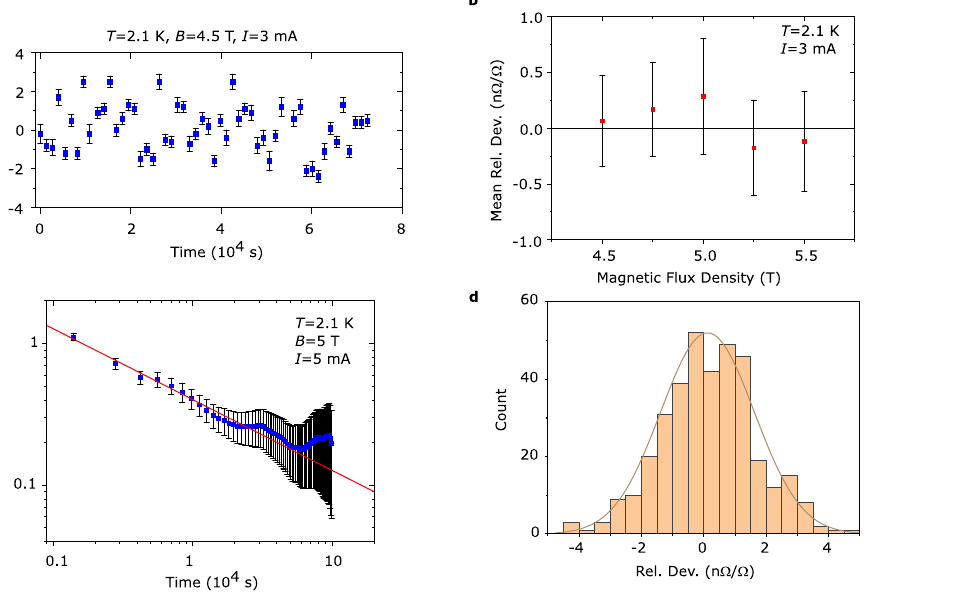
(whole array R = h /(118 e 2 )) at the N = 0 plateau. The Hall bars are